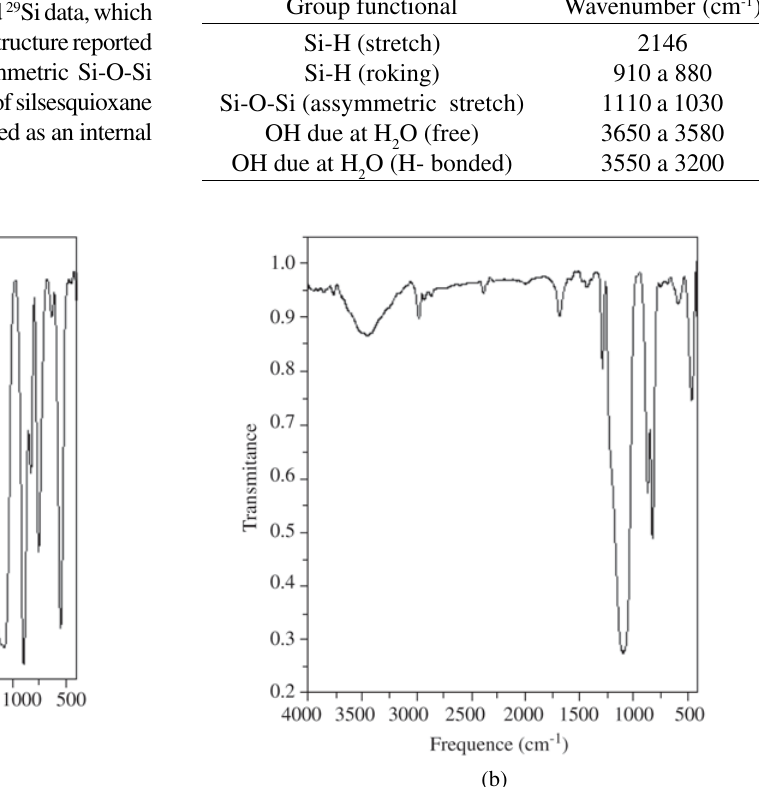
Figure 2. Infrared for composites: a) Cubes; b) octakis (chloropropyldimethylsiloxy) octasilsesquioxane.